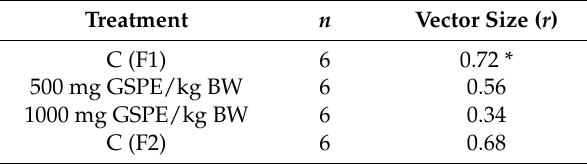
Table 1. Rayleigh z -test to measure effects on feeding pattern synchronicity.